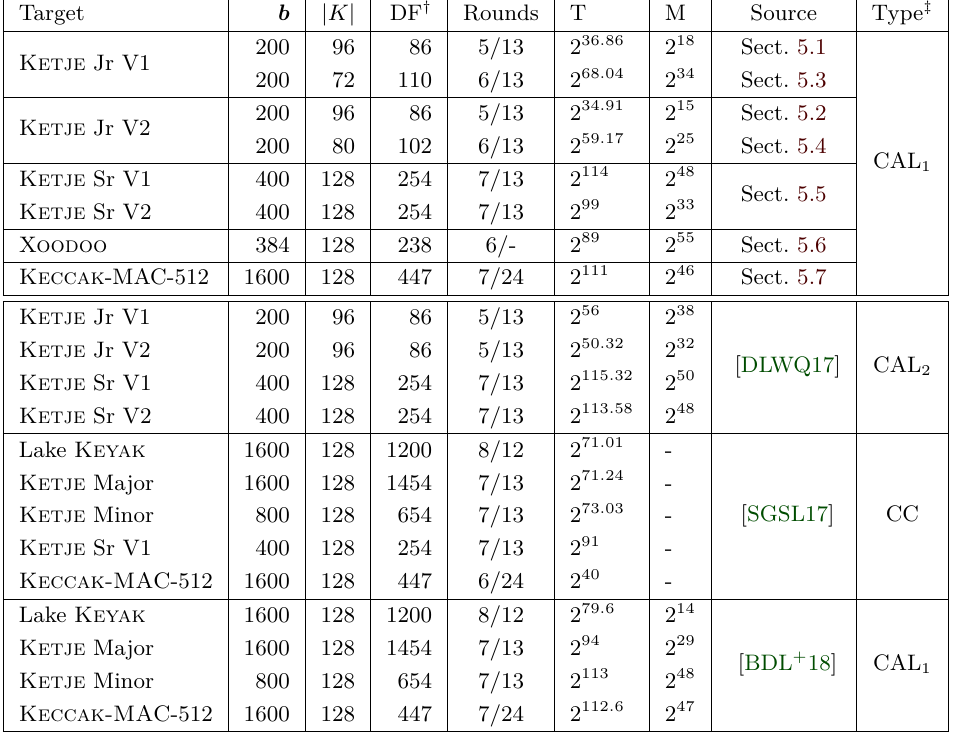
Table 1: Summary of our attacks on Ketje Jr, Ketje Sr, Xoodoo and Keccak-MAC - 512 under the nonce respected setting and comparison with related